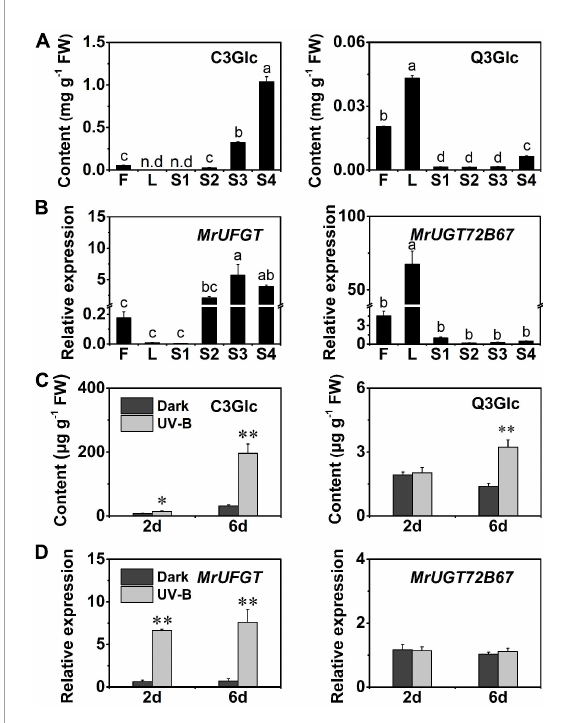
FIGURE6 Flavonoid glucosides accumulation and gene expression of MrUGT s in different tissues and UV-B-treated fruit. (A) Accumulation of cyanidin 3- O -glucoside (C3Glc) and quercetin 3- O -glucoside (Q3Glc) in flowers (F), leaves (L), and fruit development stages (S1–S4) of Morella rubra . (B) Gene expression of MrUFGT and MrUGT72B67 in different tissues. Different letters indicate significant difference between different groups ( P < 0.05). (C) Effects of UV-B irradiation on content of C3Glc and Q3Glc in M. rubra fruit. (D) Gene expression of MrUFGT and MrUGT72B67 in response to UV-B irradiation. Student’s t -test is used for statistical analyses between two samples (** P < 0.01, * P < 0.05). All data are presented as the mean ± SE ( n =